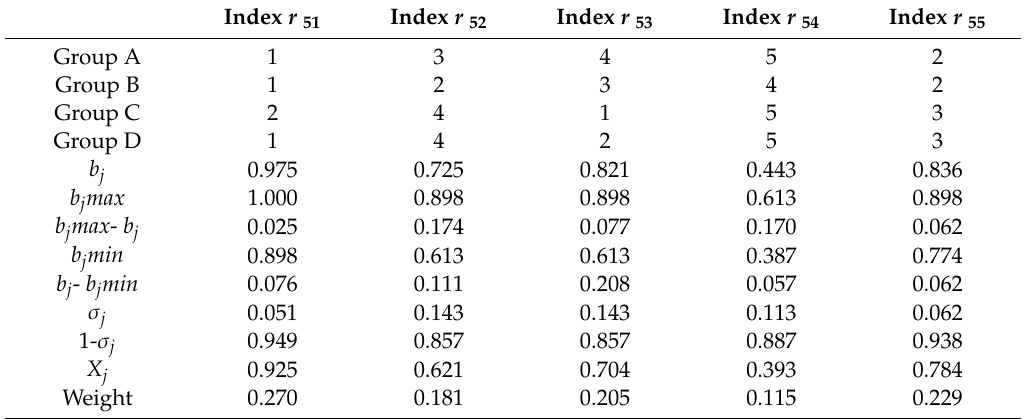
Table A6. Weight distribution of the second grade indexes of r 5.